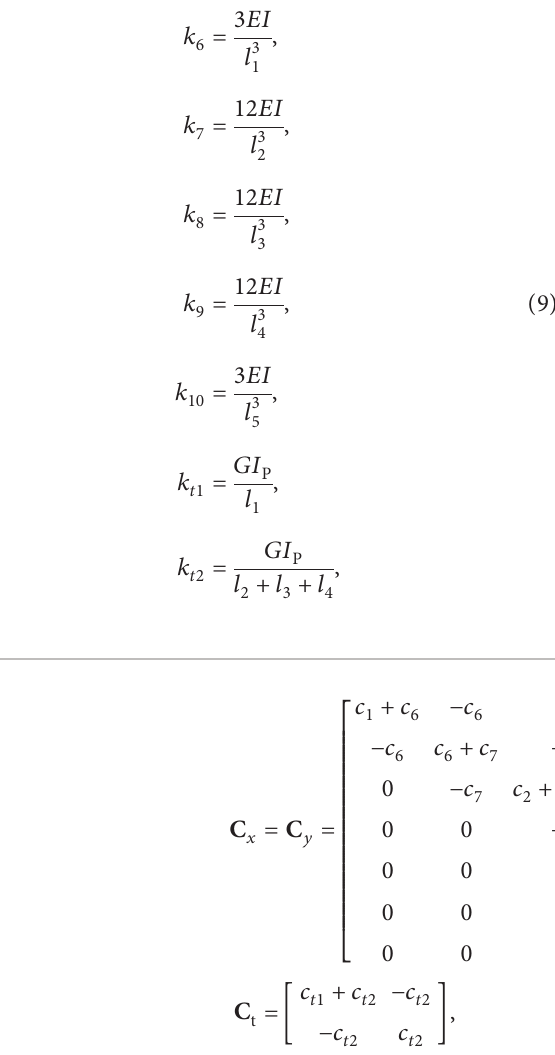
Figure 2. The inner race of the ball bearing is directly fixed on the low-pressure rotor and the outer race is directly joined together with the high-pressure rotor. We assume that the balls are arranged equidistantly at the cage of the